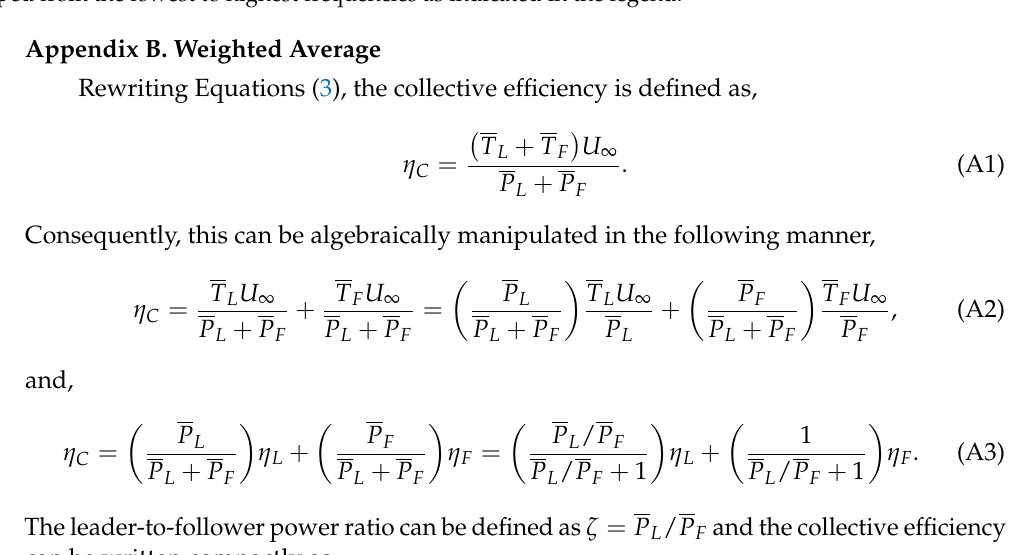
Figure A1. Isolated rigid foil ( a ) thrust coefficient and ( b ) efficiency as a function of dimensionless amplitude. The colors from blue to red are mapped from the lowest to highest frequencies as indicated in the